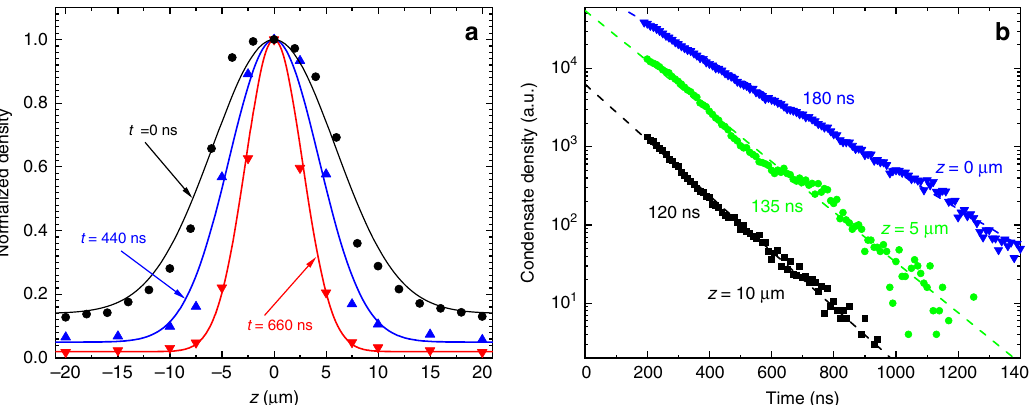
Fig. 3 Time evolution of the condensate density in a potential well after turning the microwave pumping off. a Normalized spatial pro fi les of the condensate density in a potential well with Δ H max = − 10 Oe recorded at different delays after the microwave pumping is turned off at t = 0. Solid lines are guides for the eye. b Temporal dependence of the condensate density at different spatial positions. Dashed lines show the exponential fi t of the experimental data with the corresponding effective decay times as